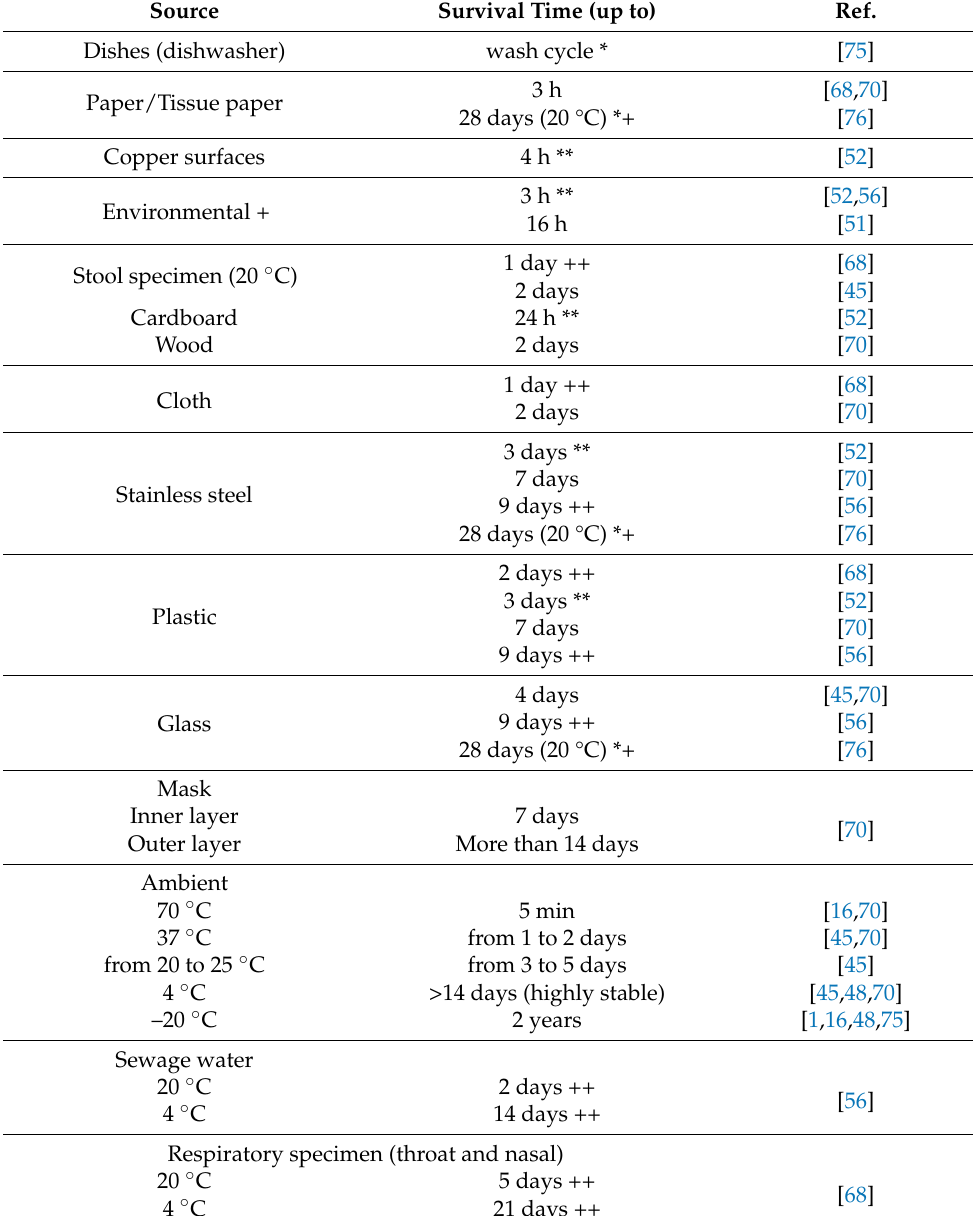
Table 3. Time that SARS-CoV-2 and other coronaviruses can remain infectious (according to environment).